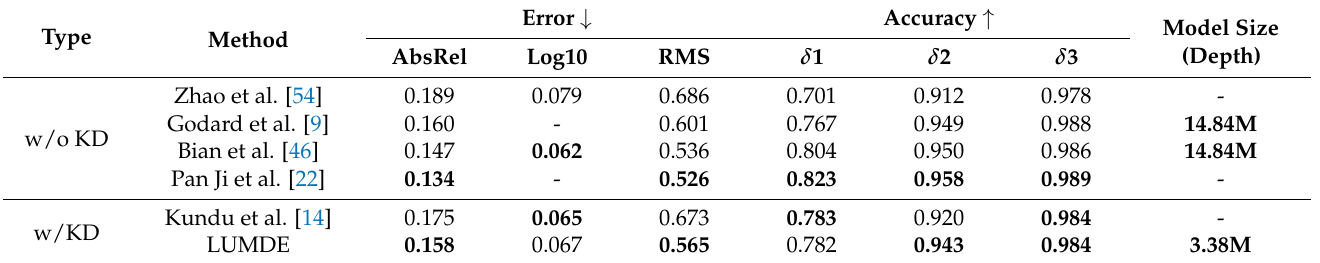
Table 6. Comparison with previous unsupervised